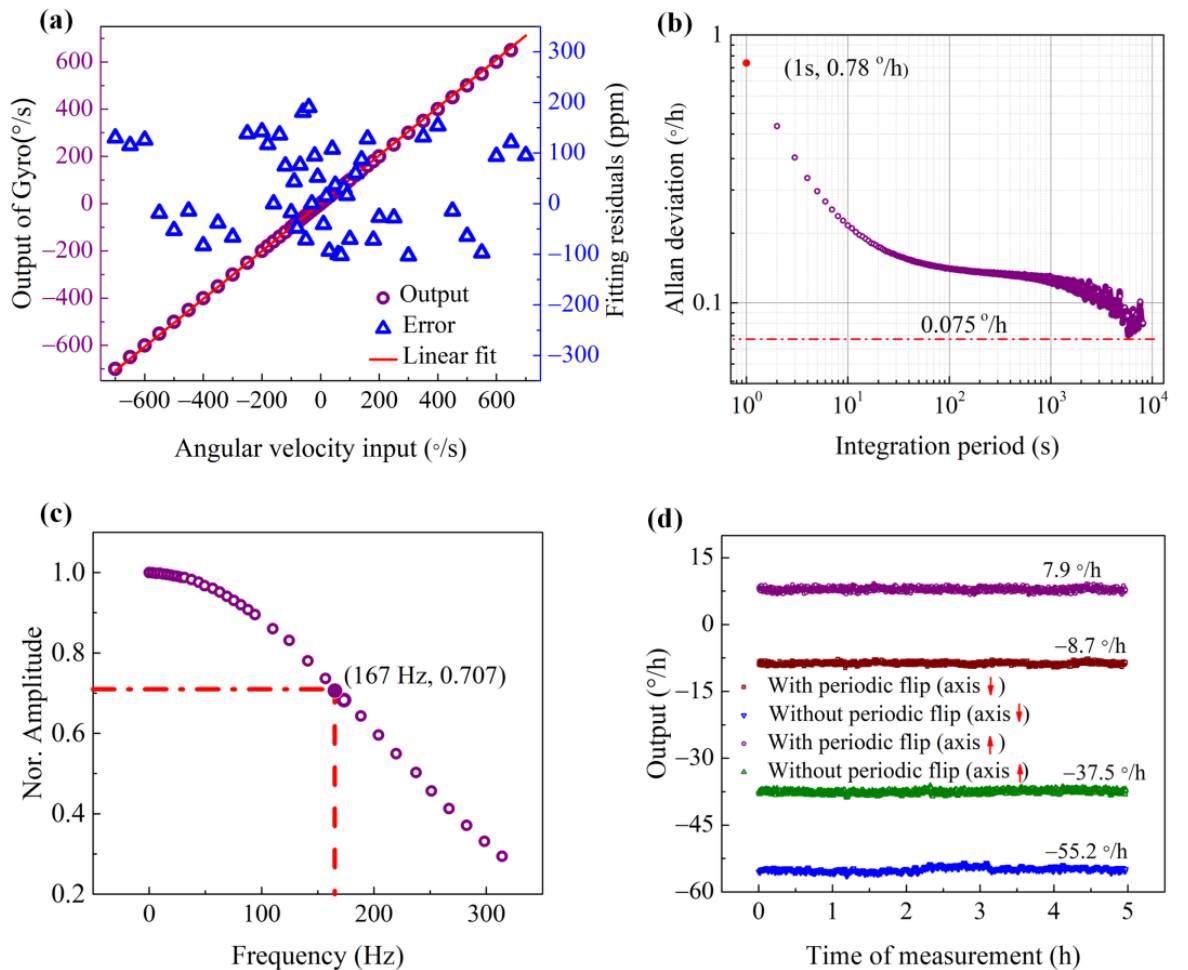
Figure 7. The measured results for our digital open-loop fiber-optic gyroscope. ( a ) Gyro output at different angular rates, ( b ) results for Allan variance testing, ( c ) gyro amplitude-frequency characteristics, and ( d ) bias comparison with the different algorithms.